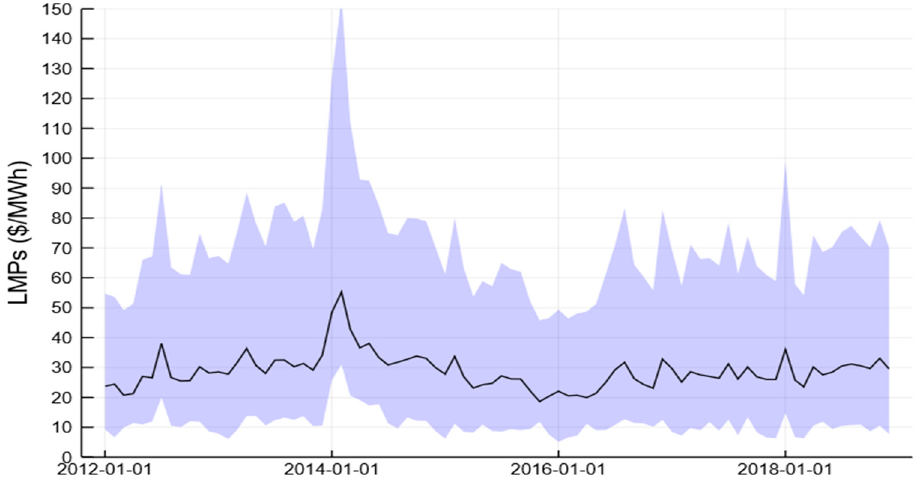
Figure 3. Monthly averages of historic, ex post hourly LMPs for all five Wisconsin utilities between 2012 and 2018, data from [21]. Monthly averages are indicated by the black line, with 10th to 90th percentiles shown as the shaded area.